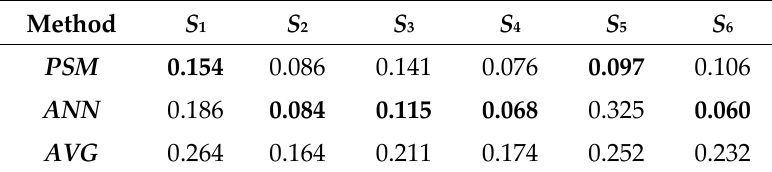
Table 4. MAPE values obtained in each segment of the route of line L 1 .